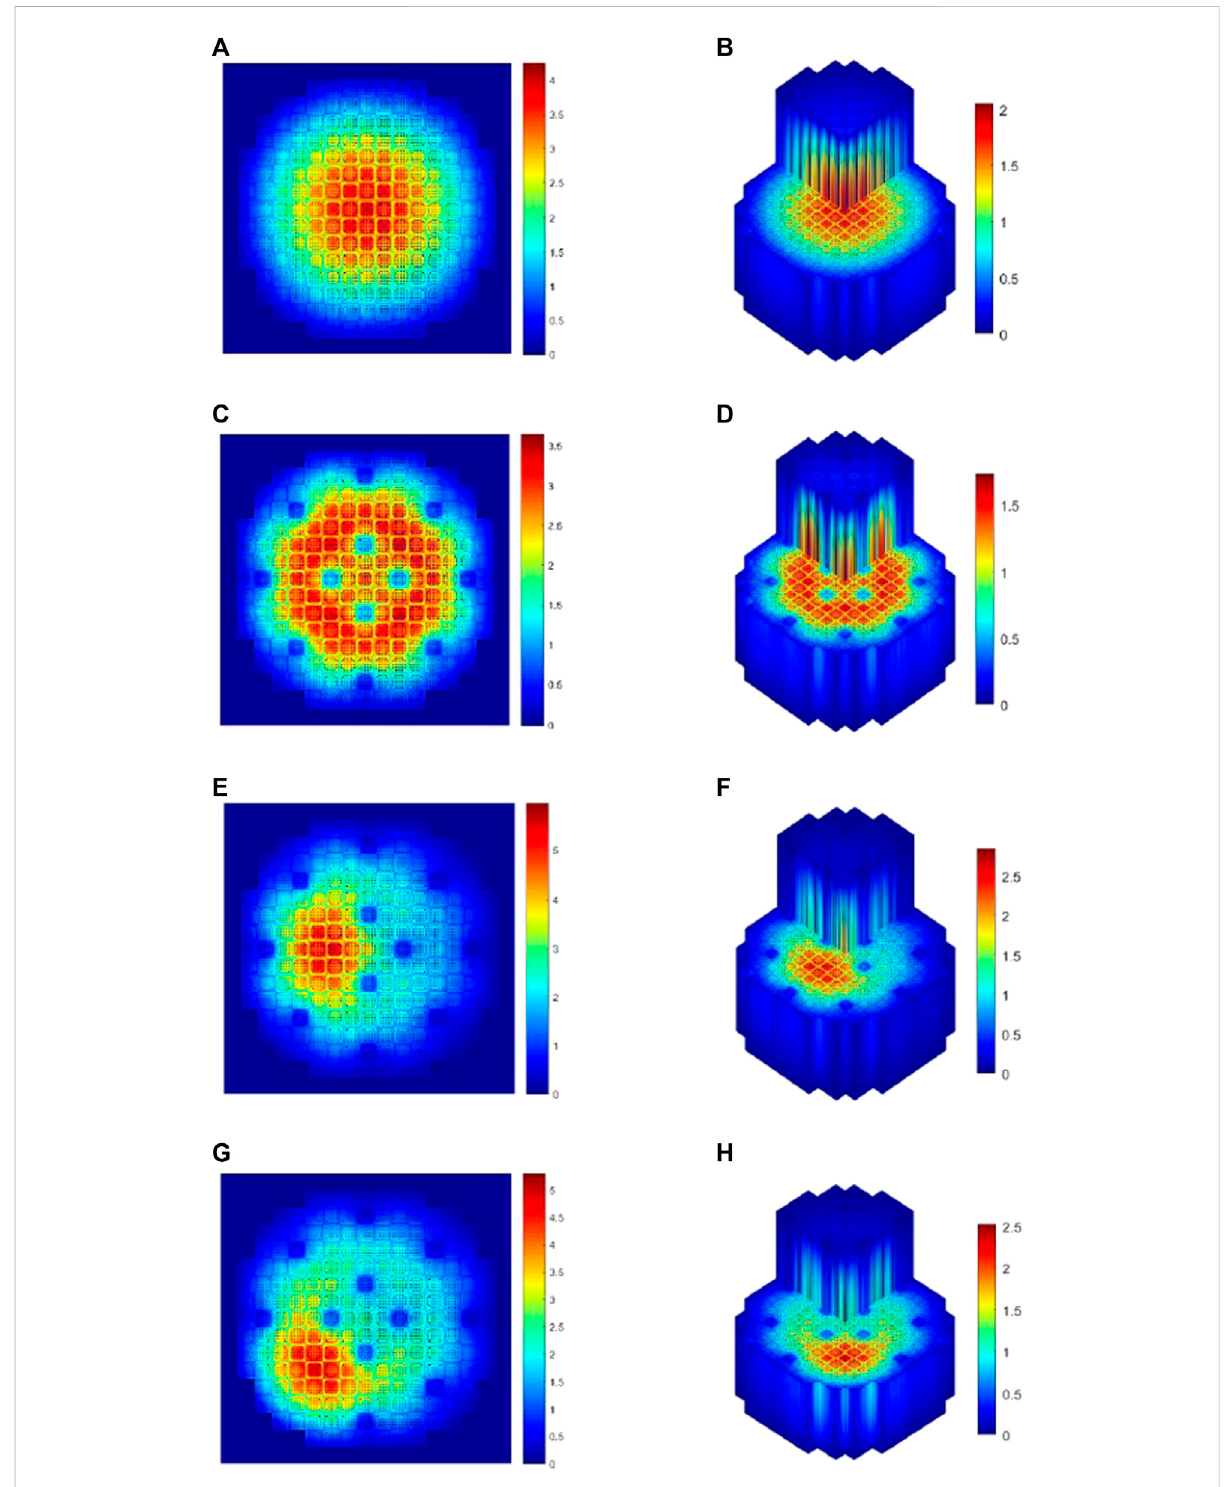
FIGURE 13 Radial average power and 3-D power density distributionfor 3-D Full-core MOX/UOX pin-by-pin models: (A) radial power density for model A, (B) 3-D power density for model A, (C) radial power density for model B, (D) 3-D power density for model B, (E) radial power density for model C, (F) 3-D power density for model C, (G) radial power density for model D and (H) 3-D power density for model